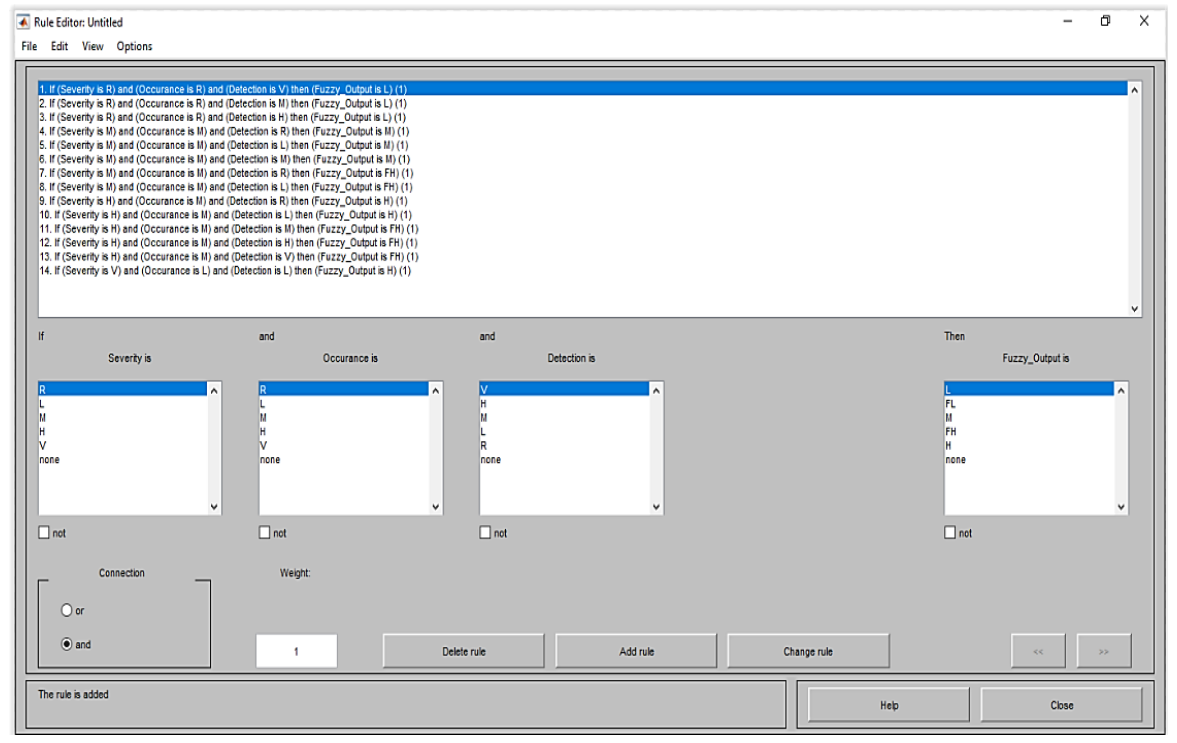
Figure 6. Setting Fuzzy Rules in Matlab.